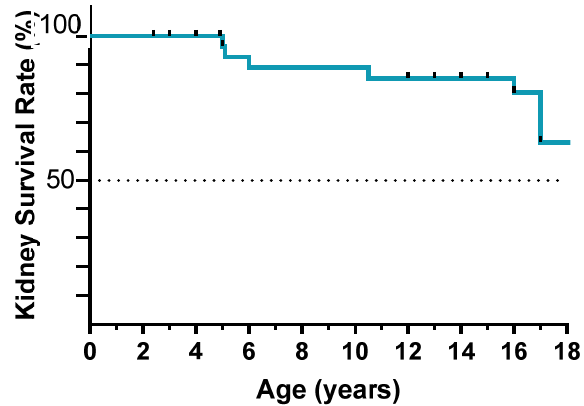
Figure 2. Kidney failure ‐ free survival until